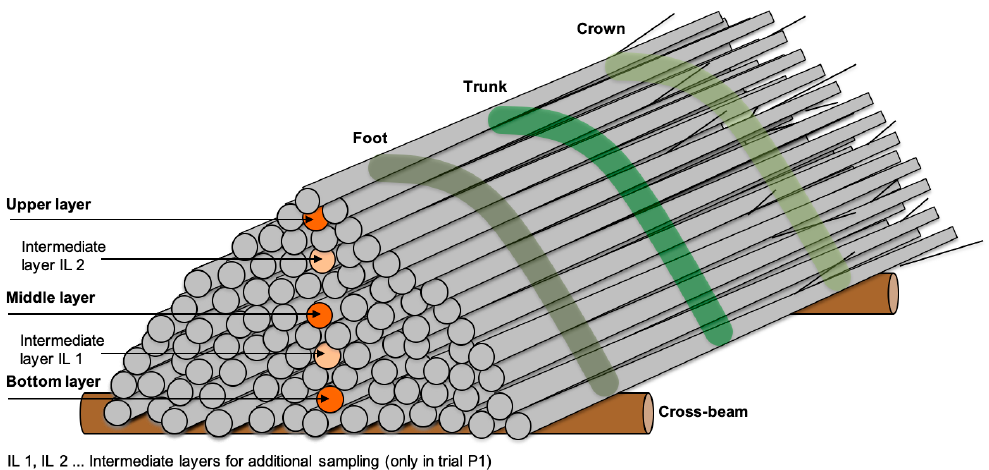
Figure 3. Schematic structure of the storage piles and the positions of the measuring levels.